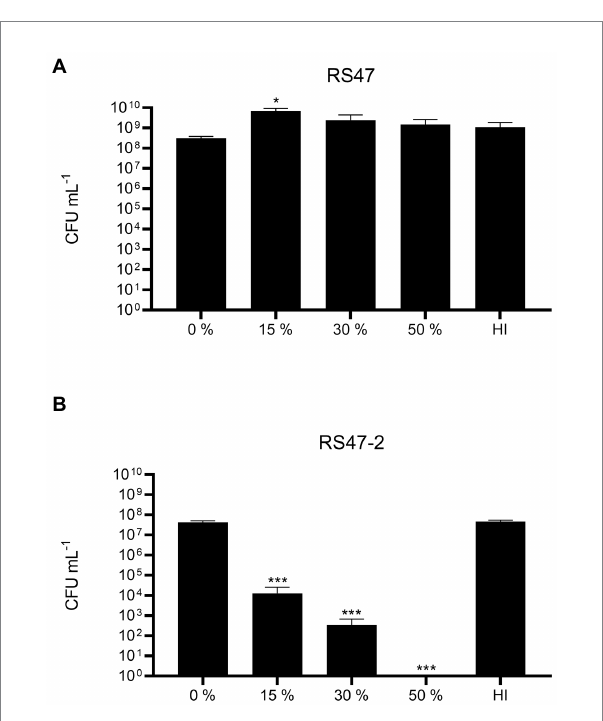
FIGURE 3 Impact of LPS alterations on survival in NHS. (A) Survival of WT RS47 in normal human serum (NHS). (B) Survival of RS47-2 in NHS. Heat inactivated serum (HI) was included as a control. Figures show the mean of three biological replicates. Error bars show standard error of the mean (SEM). Ordinary one-way ANOVA with Dunnett’s post hoc test were performed, comparing bacterial survival in NHS to the 0 % serum input control. * p ≤ 0.05. *** p ≤